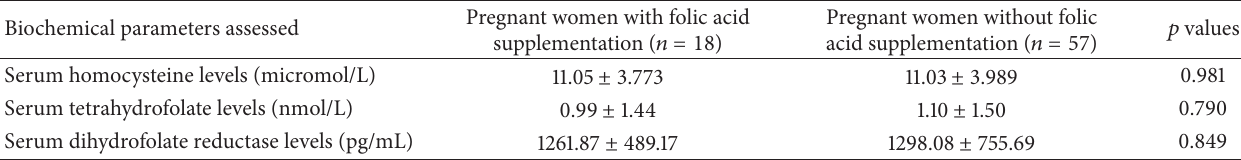
Table 2: Serum levels of homocysteine, tetrahydrofolate, and dihydrofolate reductase in pregnant women ( 𝑁 = 76